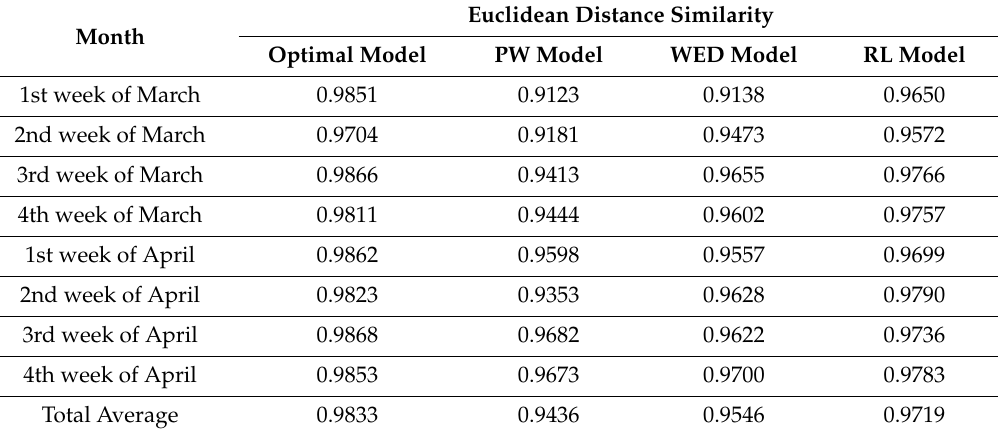
Figure 11. Similar day selection performance results for the models by day of week. Table 4. Similar day selection performance results in March and April 2018.